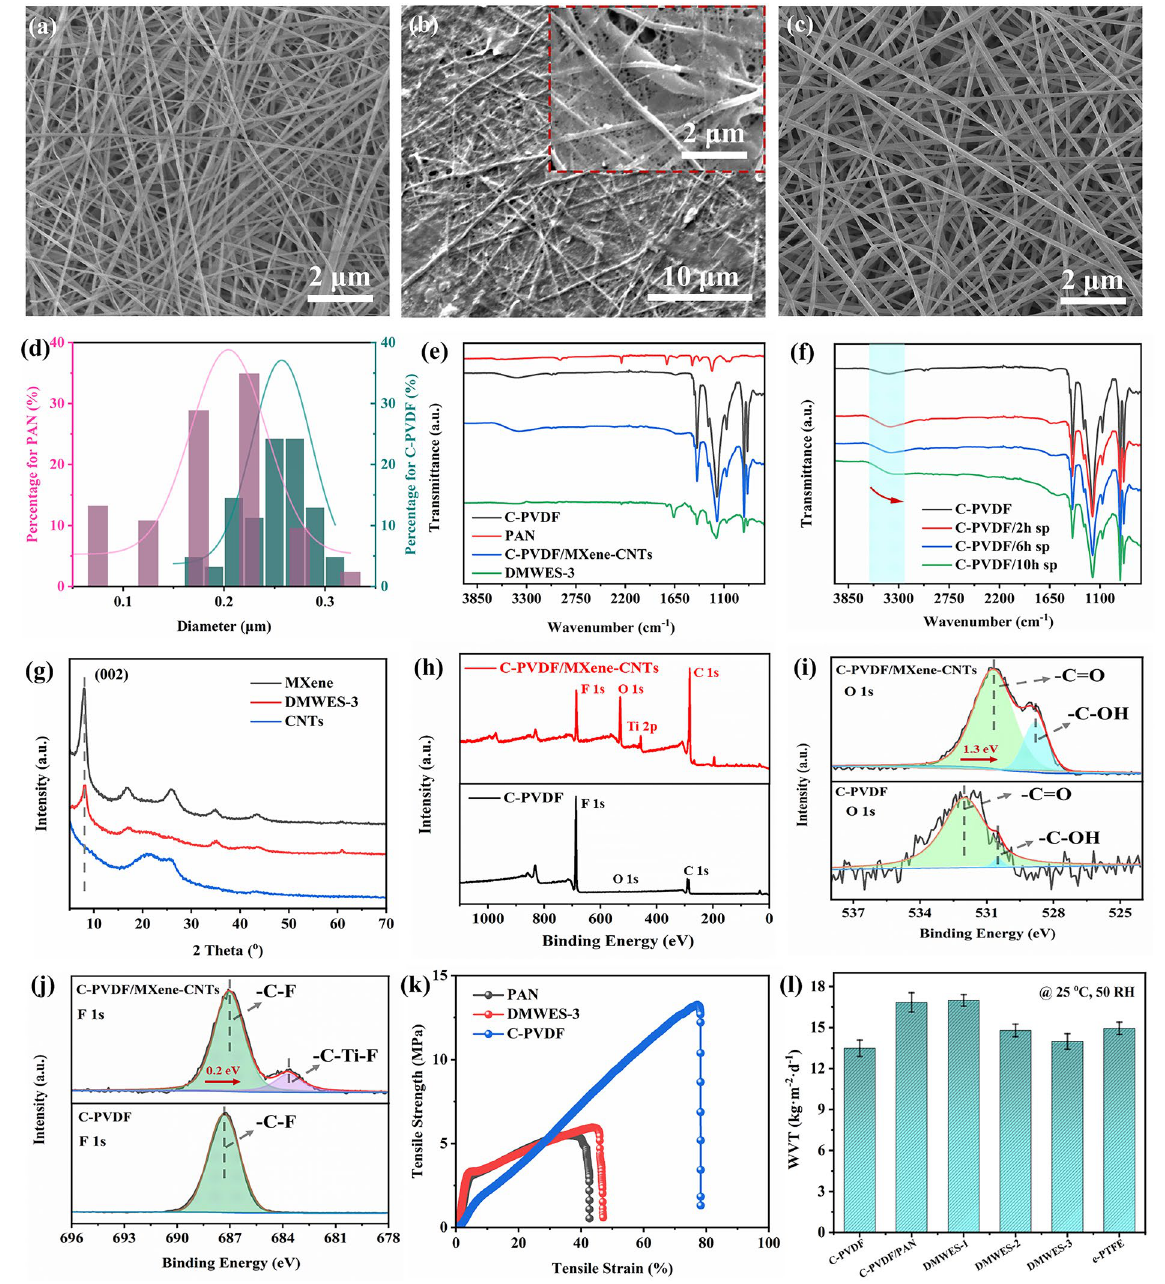
Fig. 2 Material characterization of the DMWES. a SEM image of C-PVDF nanofibers layer. b SEM image of C-PVDF/MXene-CNTs layer, the inset is enlarged image. c SEM image of PAN nanofibers layer. d Diameter distribution of the C-PVDF nanofibers and PAN nanofibers. e FT-IR measurement of the products. f FT-IR measurement of the C-PVDF with different time of electrospraying MXene/CNTs. g XRD patterns of the products. h XPS survey scan of the C-PVDF and C-PVDF/MXene-CNTs. i, j O 1 s and F 1 s XPS scan spectra of the C-PVDF and C-PVDF/ MXene-CNTs. k Tensile strength curve of the products. l Water vapor transfer rate (WVT) of the